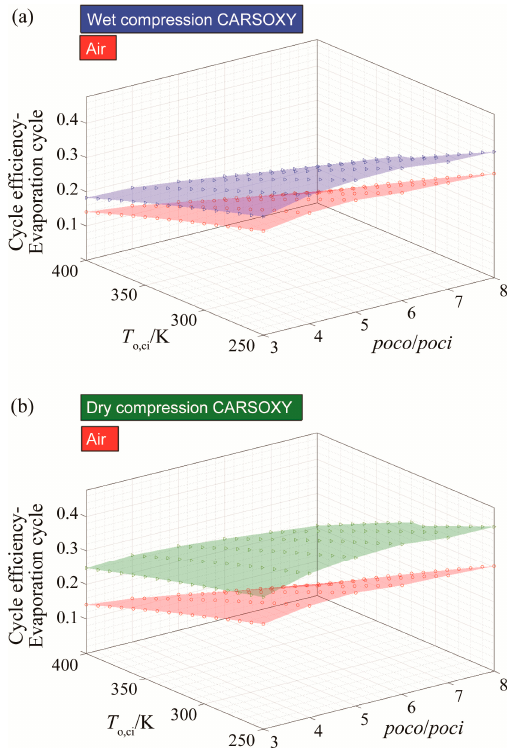
Figure 5. Efficiency results for the evaporative cycle using ( a ) wet compression and ( b ) dry compression.